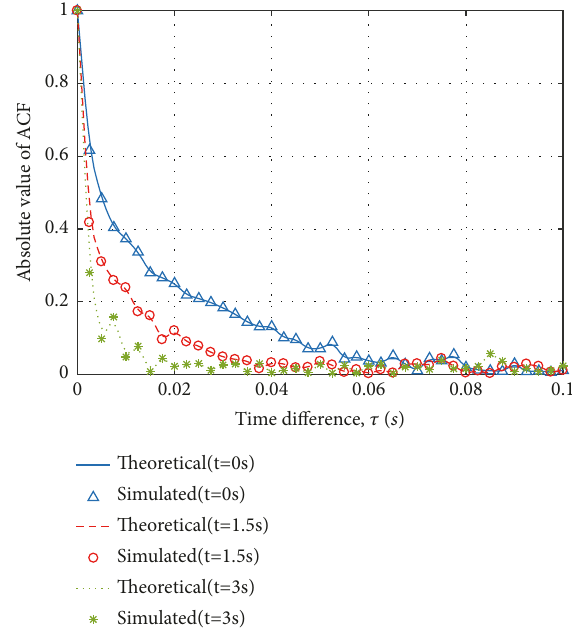
Figure 4: Absolute values of the theoretical and simulated TV-ACF |𝑟 (𝑡, 𝜏)| at different time instants ( 𝐾 𝑝𝑞